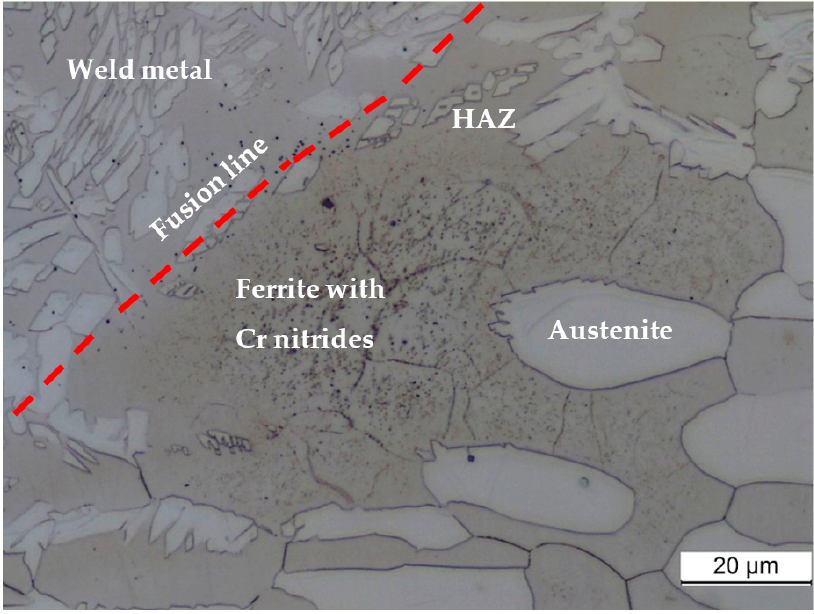
Figure 10. HAZ microstructure.